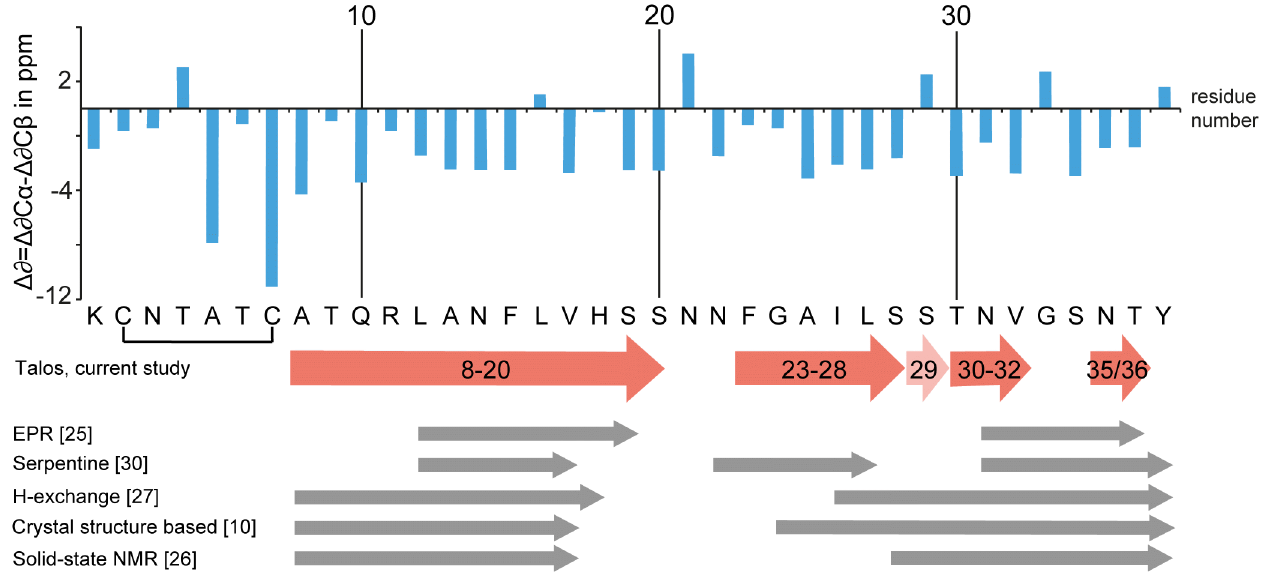
Fig 6. The location of β -strands in fibrillar IAPP. Top, calculated differences of secondary chemical shifts Δ δ C sec = Δ δ C α - Δ δ C β , with Δ δ C x = δ C δ C x (exp) - x (BMRB). Two or more adjacent negative values usually are indicative of a predicted by TALOS-N based on NMR chemical shifts from the current study (except for residues A5, T6 and C7, which are part of the disulfide bridged N-terminal loop). Position S29 is found to be structurally less constrained and able to form part of a β -strand in a fraction of fibrils. Grey bars indicate the location of β -strands as determined in previous